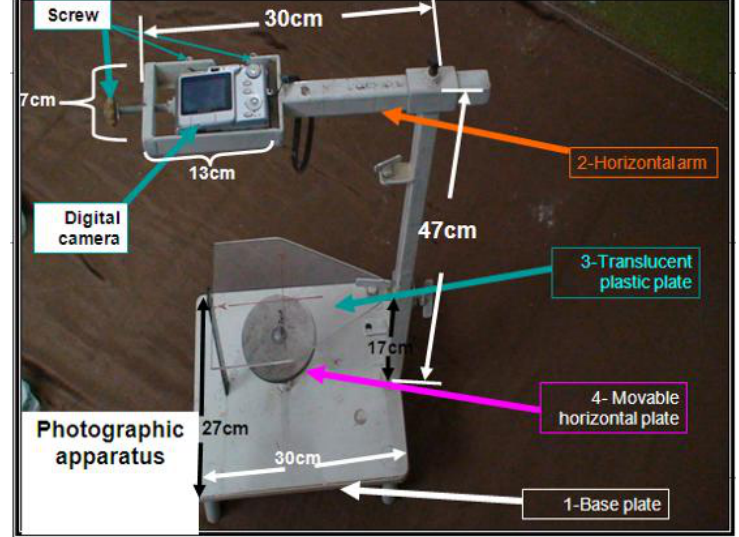
Fig. 1: Photographic Apparatus